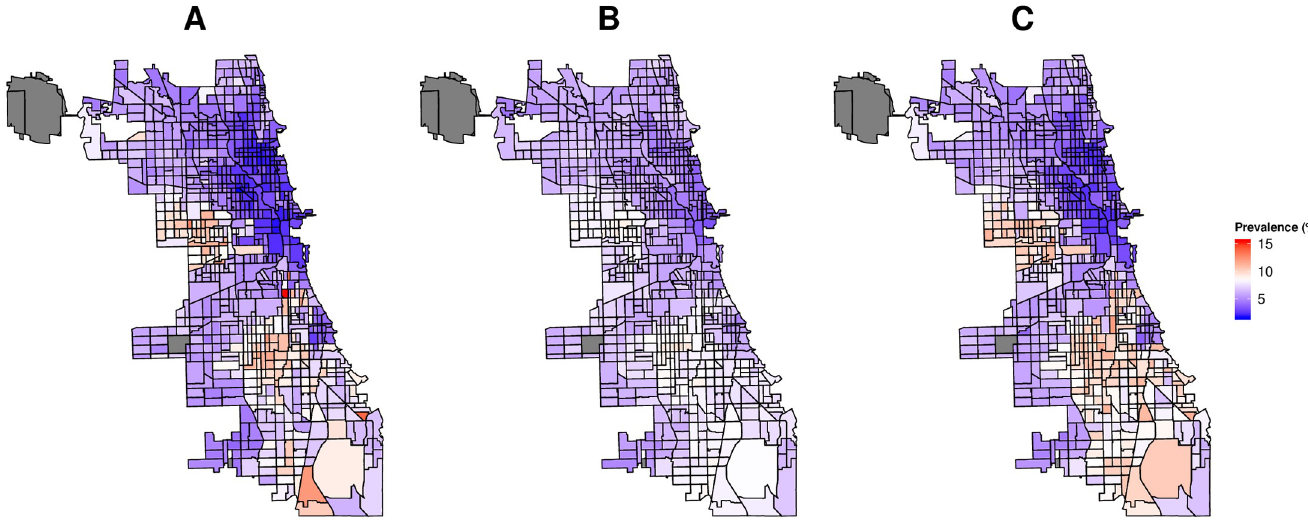
Fig 6. Census tract level prevalence of COPD for the city of Chicago in U.S. A: Ground truth as estimated by CDC. B: Estimates from search query based model. C: Estimates from model based on search queries, land cover and census data. Greyed areas show census tracts for which data was not available from any one of the data